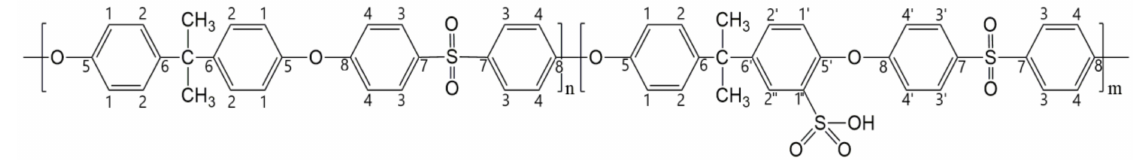
Figure 5. SPSf with numbered protons.